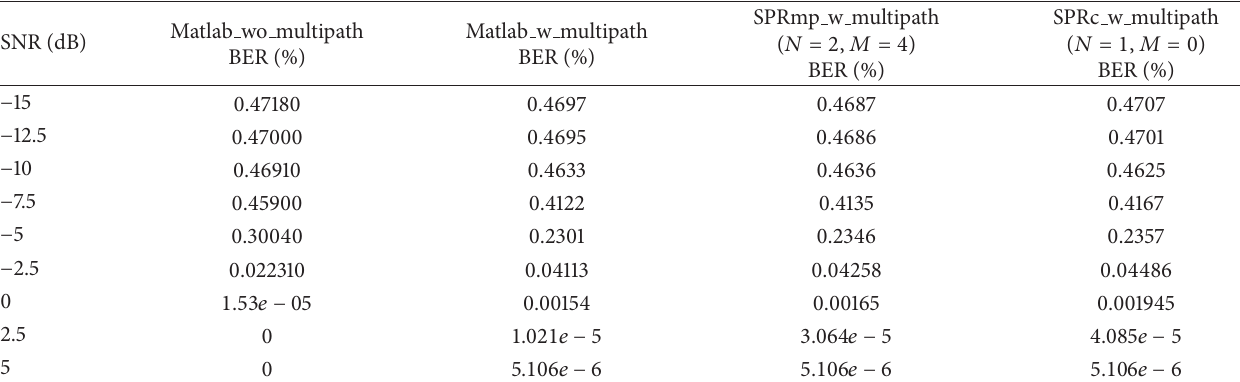
Table 2: Estimated EVMs of receiver FE at all SNRs.